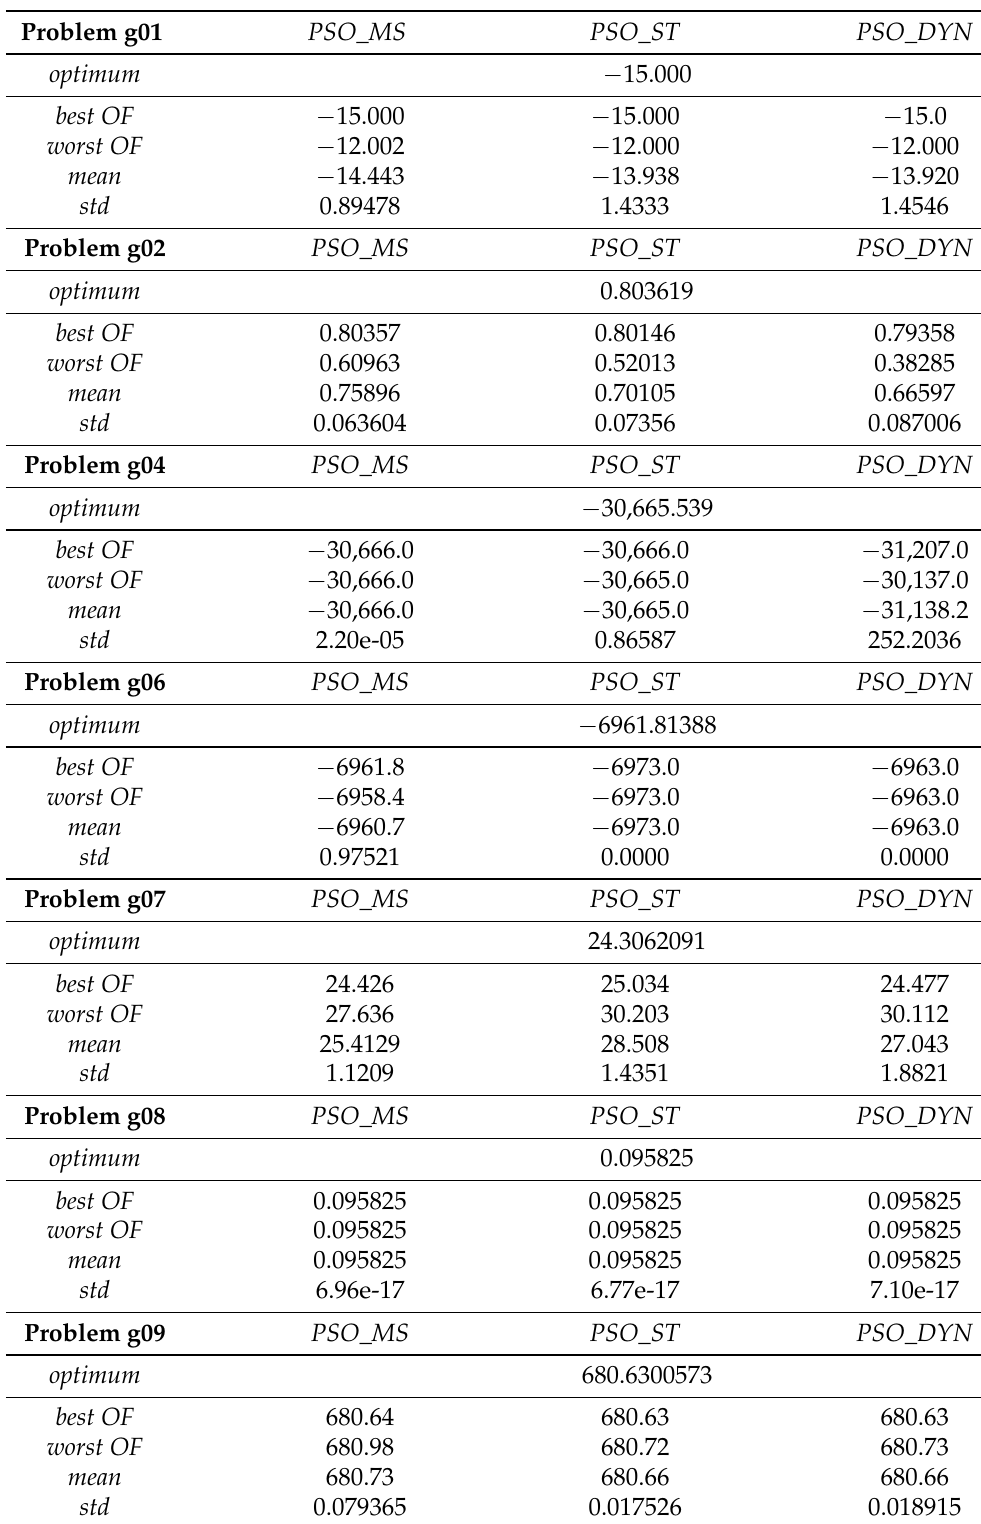
Table 1. Selected numerical benchmark examples taken from [53] and comparisons of the final results for 50 runs among the enhanced multi-strategy PSO ( PSO_MS ), the PSO with static penalty ( PSO_ST ), and the PSO with dynamic penalty ( PSO_DYN